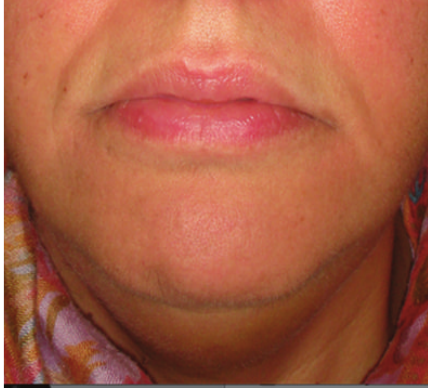
Figure 5: Axial computed tomography image showing almost complete regression of haematoma, normal dimension of upper airways spaces, and normal position of the